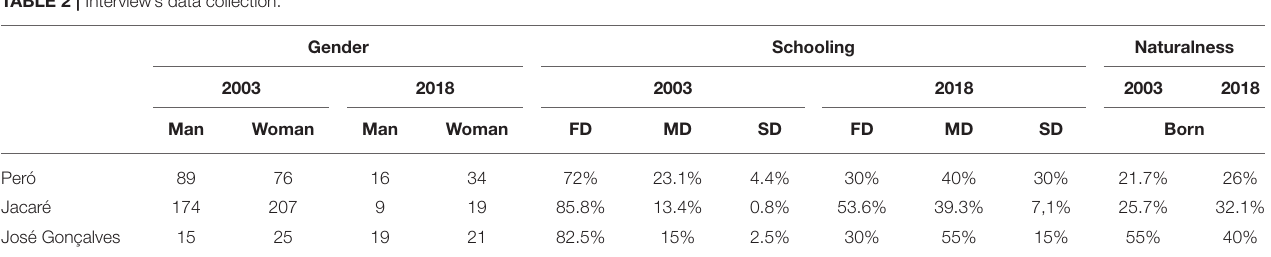
TABLE 2 | Interview’s data collection.